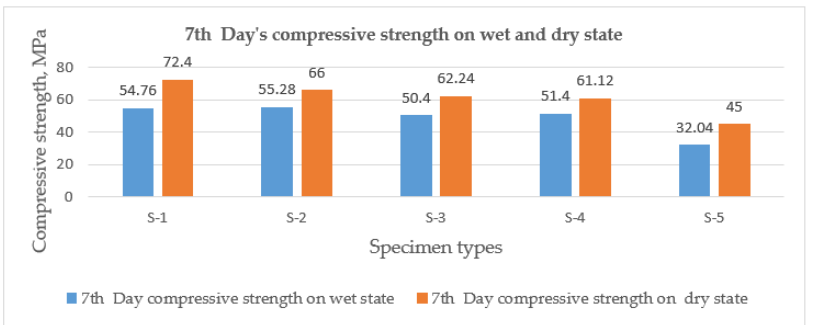
Figure 4. 7th day Compressive strength of concrete samples on wet and dry state.